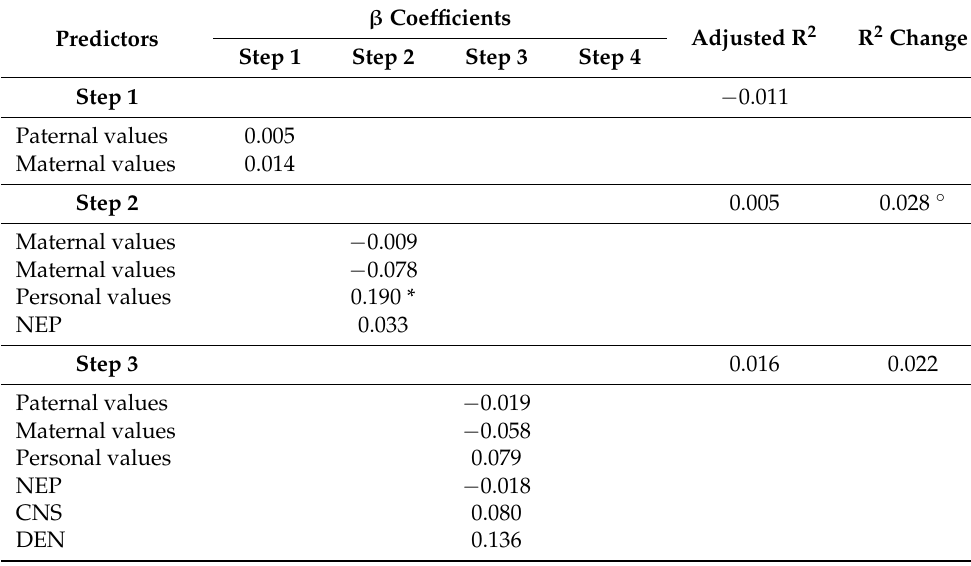
Table 7. HMRA: predictors of sustainable